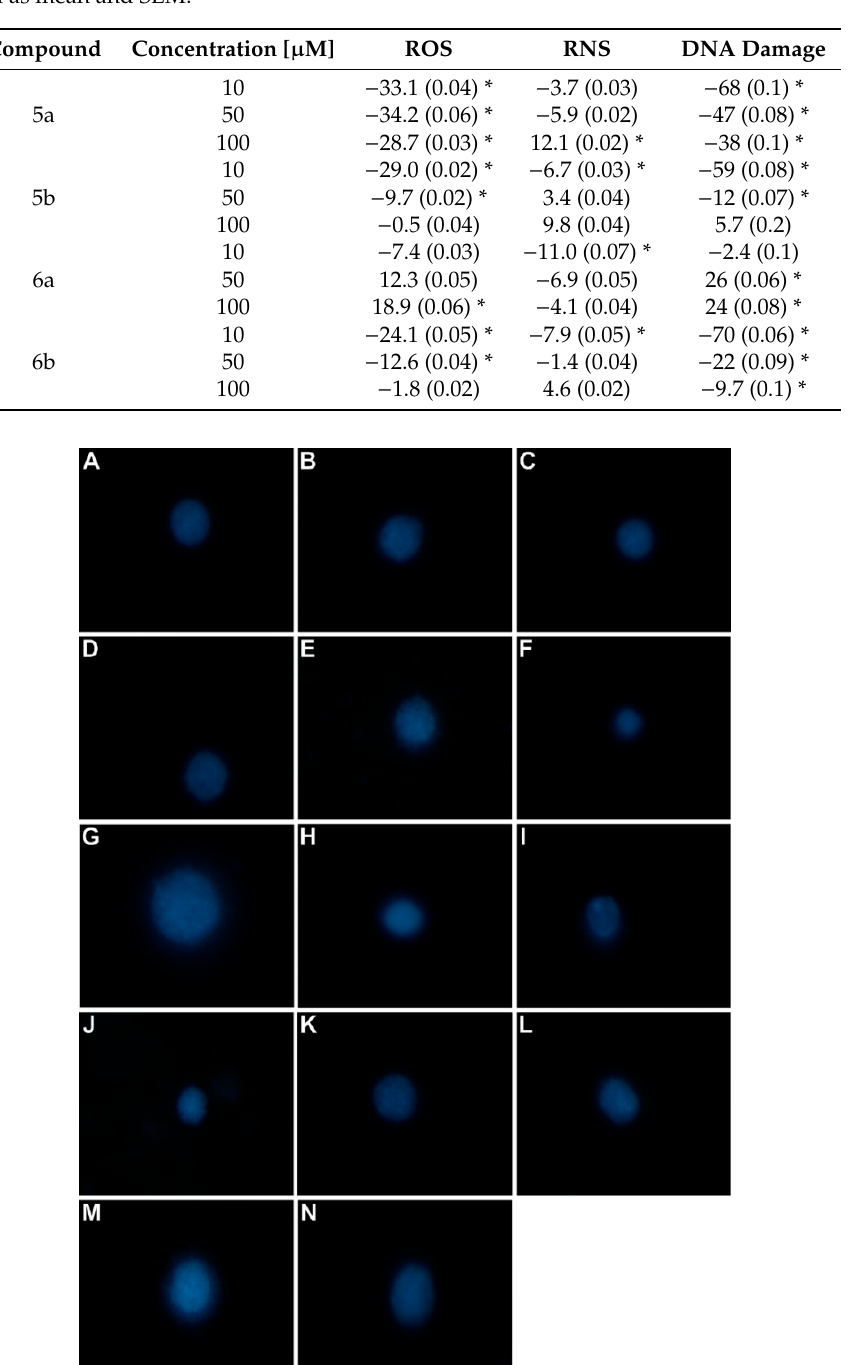
Table 3. Reactive oxygen species (ROS) and reactive nitrogen species (RNS) scavenging activity of tested compounds and an impact on the DNA damage ( n = 3); the results were compared to the positive control and expressed as E / E 0 ratios; statistical significance calculated with post-hoc test compared to control (* p < 0.05; E0—culture incubated with 100 µ M H 2 O 2 but without test compounds); data are presented as mean and